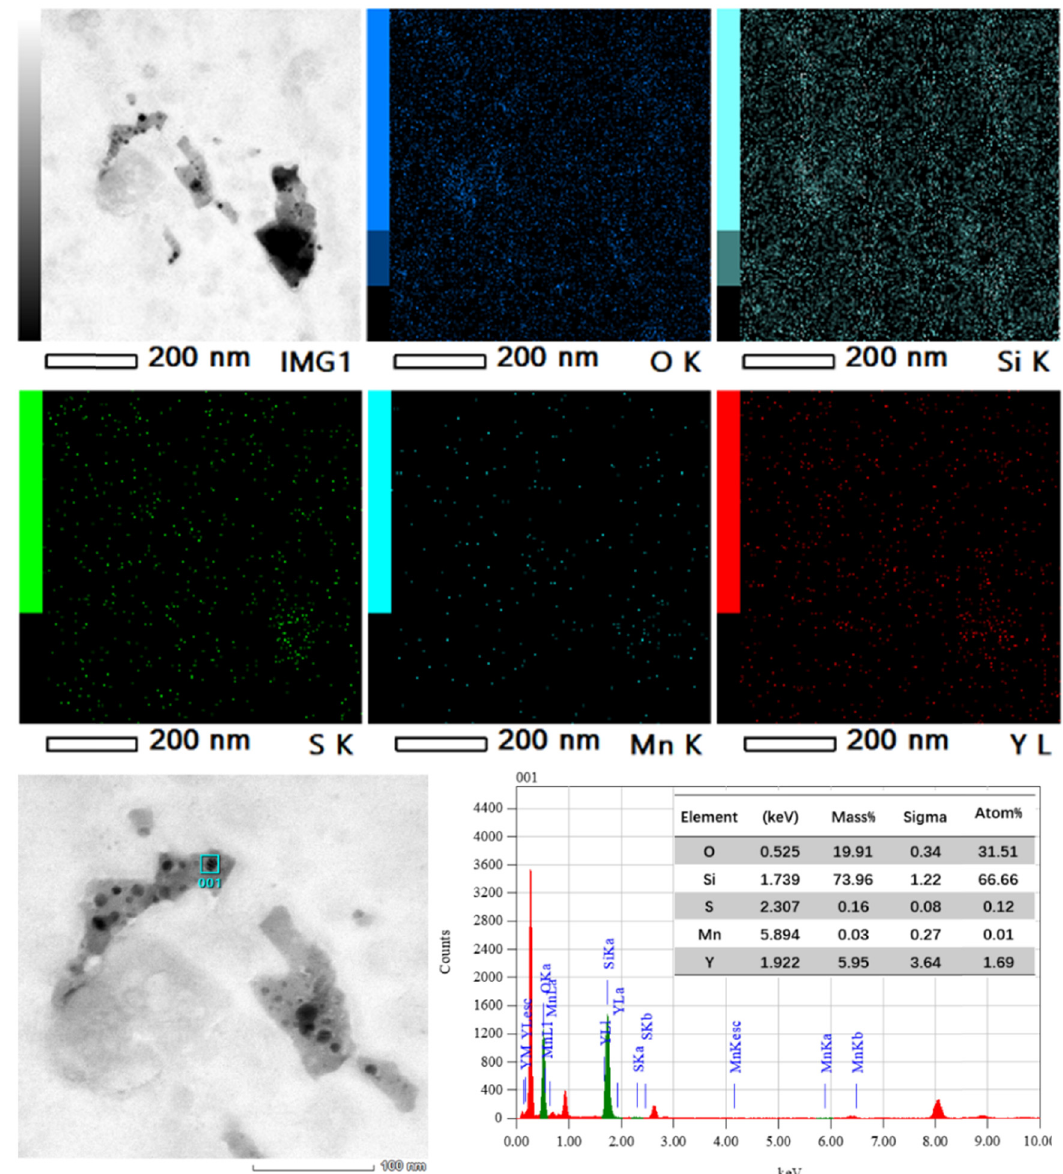
Figure 8: Composition distribution of fi ne precipitates in Y - bearing